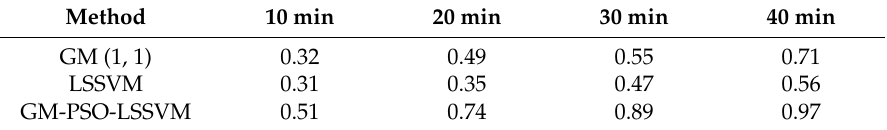
Table 3. Forecasting execution time in different predicted time length (unit: second).